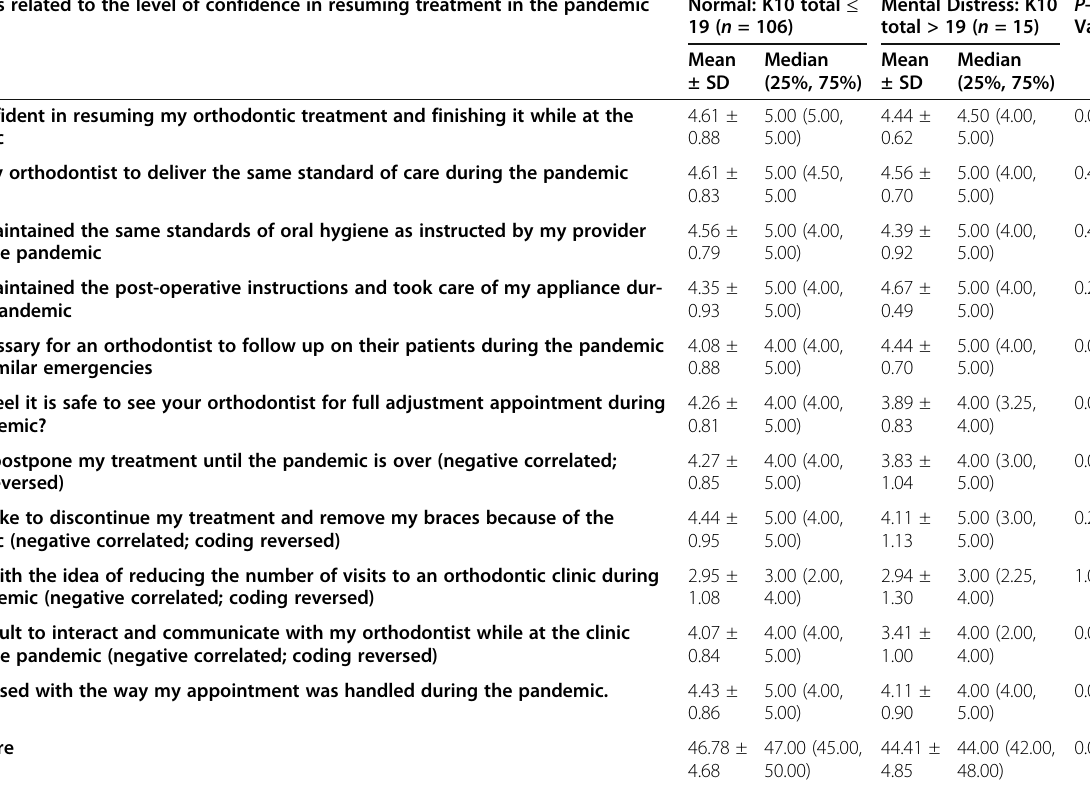
Table 8 Comparison of orthodontic patients ’ level of confidence in resuming treatment during the pandemic between normal and mental distress groups by the Kessler scale using two-sided Mann-Whitney U tests. P <